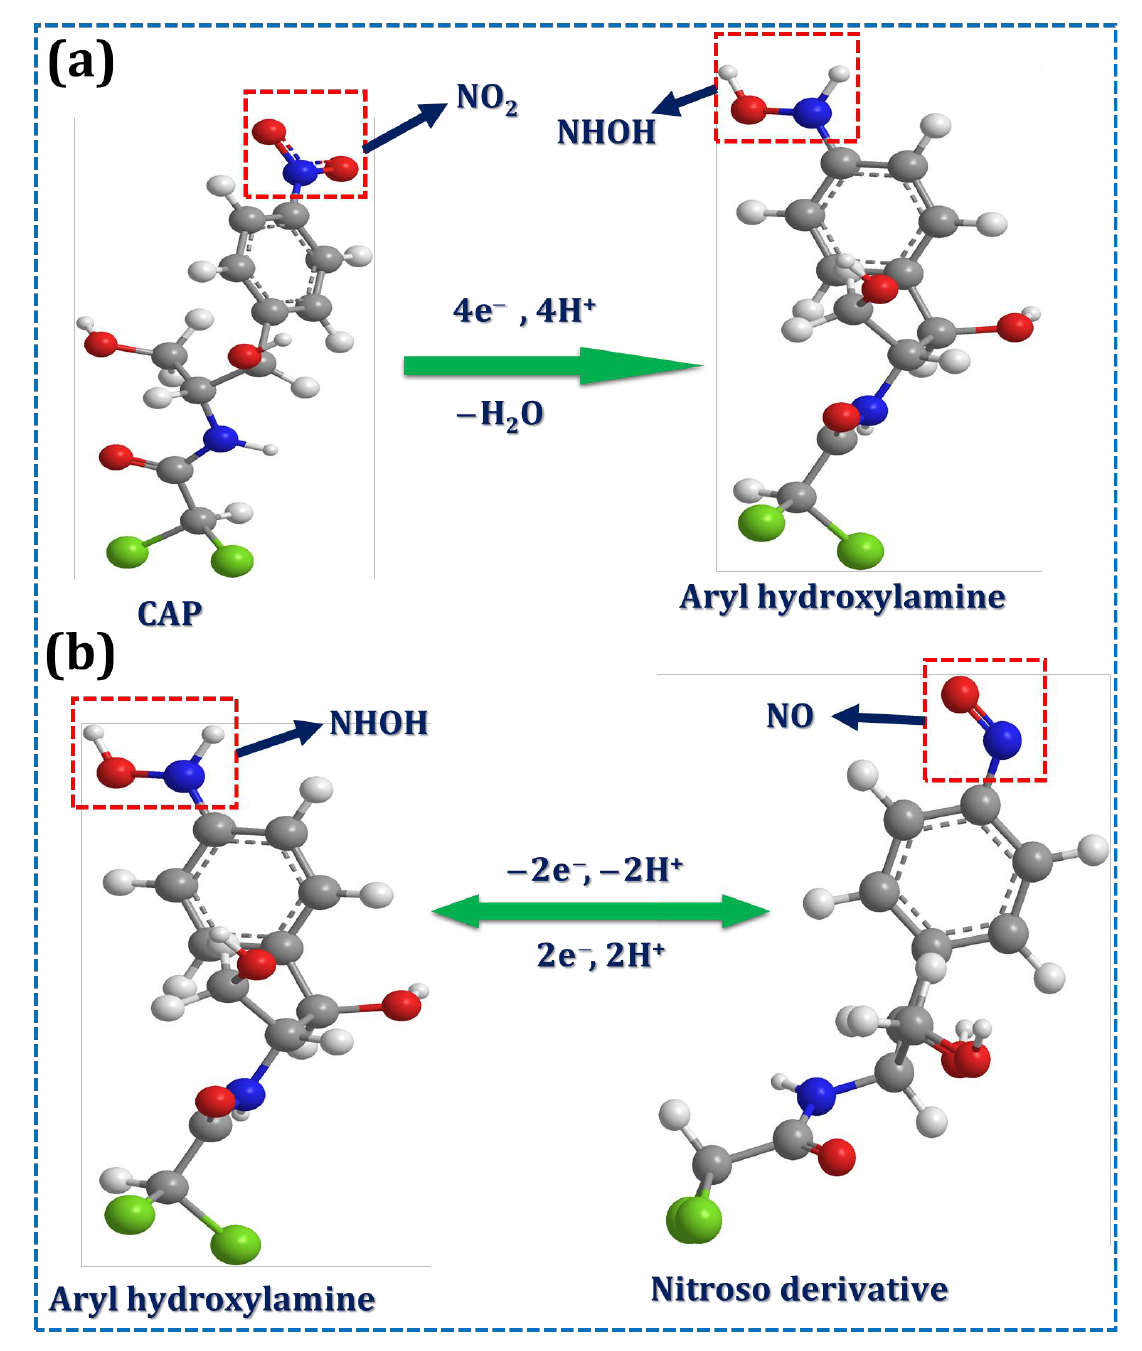
Scheme 2. Plausible electrochemical mechanism of CAP.